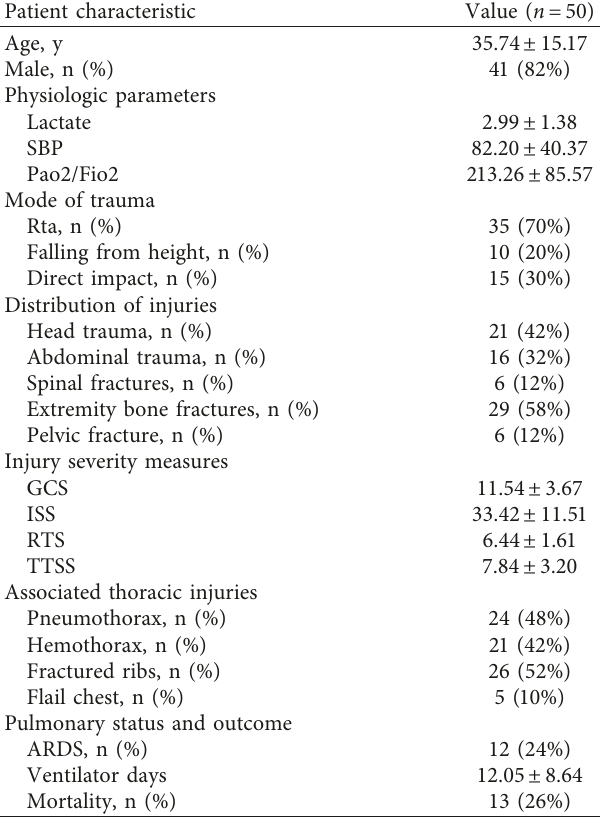
Table 1: Patient characteristics and scores. Patient